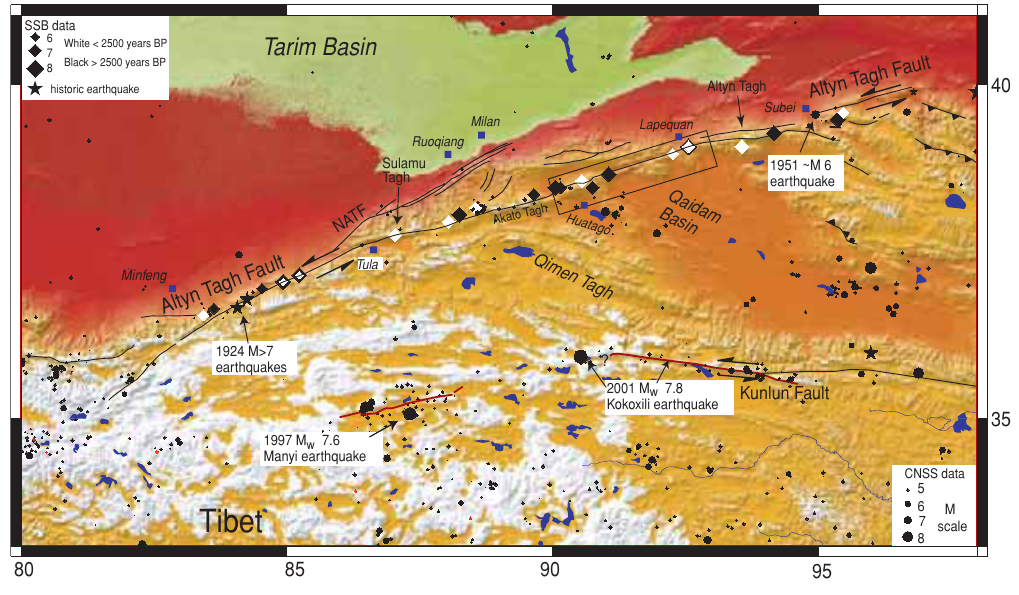
Fig. 2. Overview map showing the Central Altyn Tagh Fault (ATF), location of study area (rectangular box, fig. 3), instrumental seismicity (Council of the National Seismic System (CNSS); http://quake.geo.berkeley.edu/cnss/cata- log-search.html), historic earthquakes (Chinese Catalog of Historic Strong Earthquakes 2300 B.C. to A.D., 1991), paleoearthquakes (State Seismological Bureau (SSB); Ge et al. , 1992), and major towns. The Ge et al. (1992) data are plotted at the reported locations with their inferred magnitude and color-coded by age range. The events most relevant for this study are < 2500 years BP (white). The low seismic activity is unexpected because the ATF is thought to accommodate a significant portion of India-Asia convergence. The historical record also shows fewer earthquakes than anticipated. North Altyn Tagh Fault (NATF) mapping from Cowgill et al. (2000). Manyi earthquake surface rupture from Peltzer et al. (1999) and Kokoxili earthquake location and approximate surface rupture are from van der Woerd et al. (2002) and Lin et al. (2002). Base figure generated from GTOPO30 1 km digital elevation data set using GMT (Wessel and Smith,